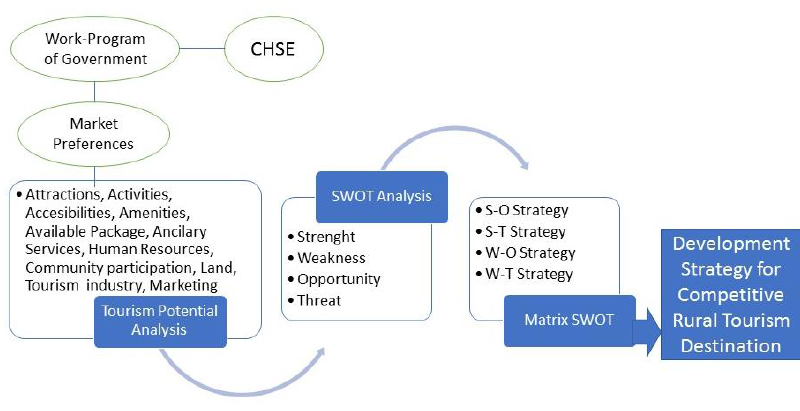
Figure 1. The Conceptual framework in the